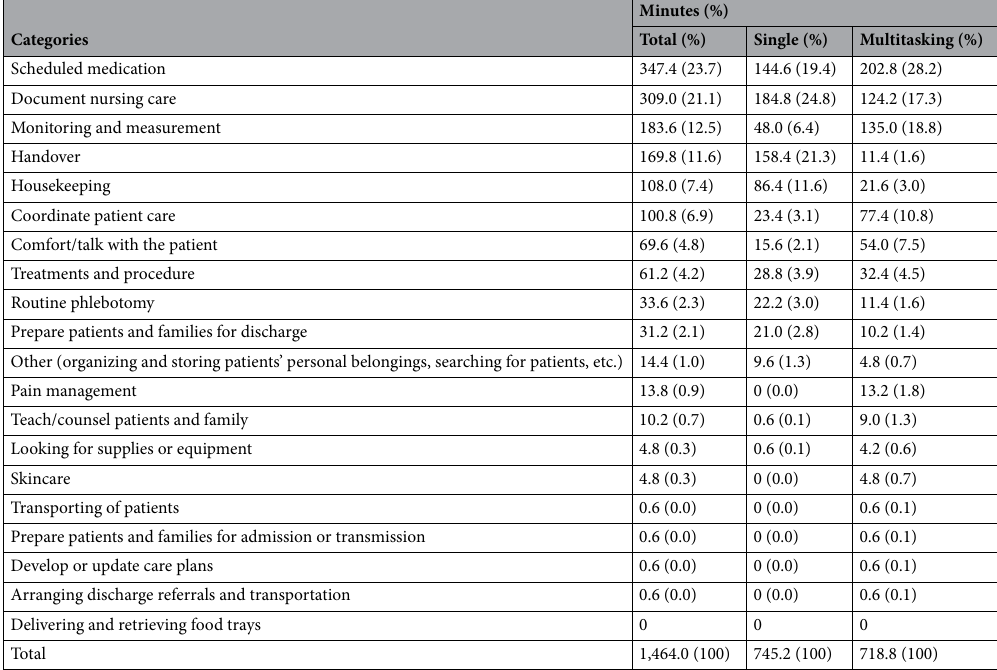
Table 4. Duration of each nursing activity